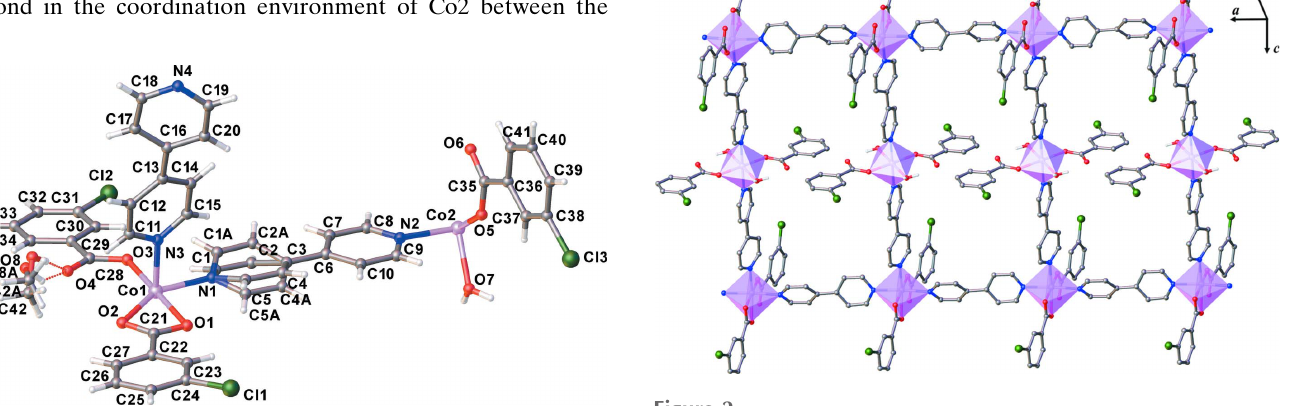
Figure 2 View of the ladder-chain structure along the a- axis direction. The hydrogen atoms located at carbon atoms and methanol solvate molecules are omitted for clarity.